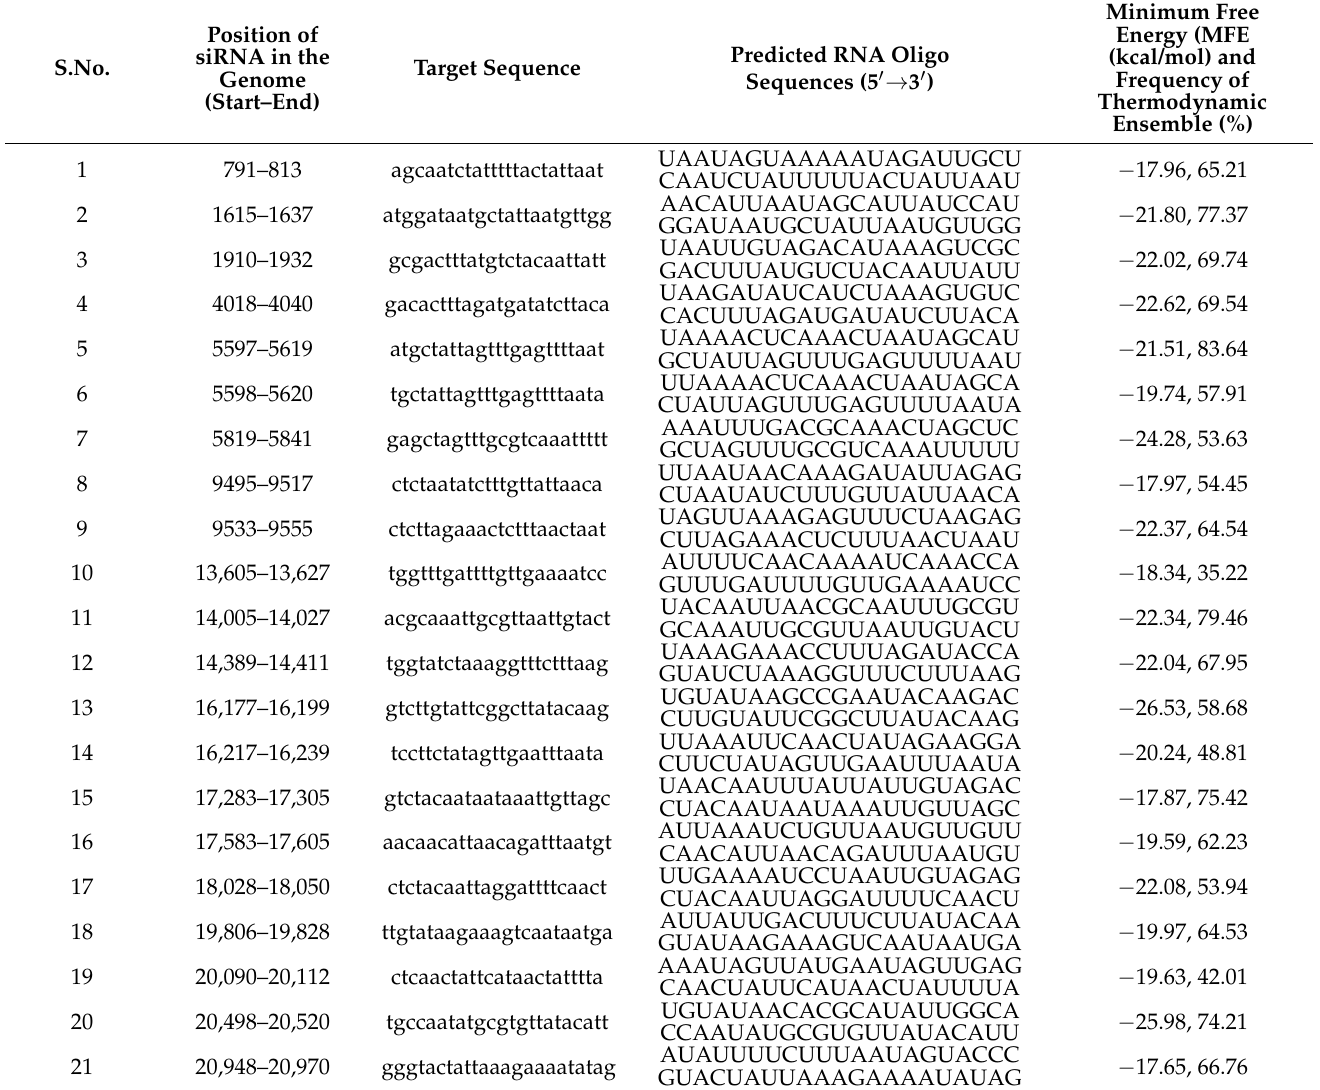
Table 1. List of designed and filtered siRNAs from the orf1ab region